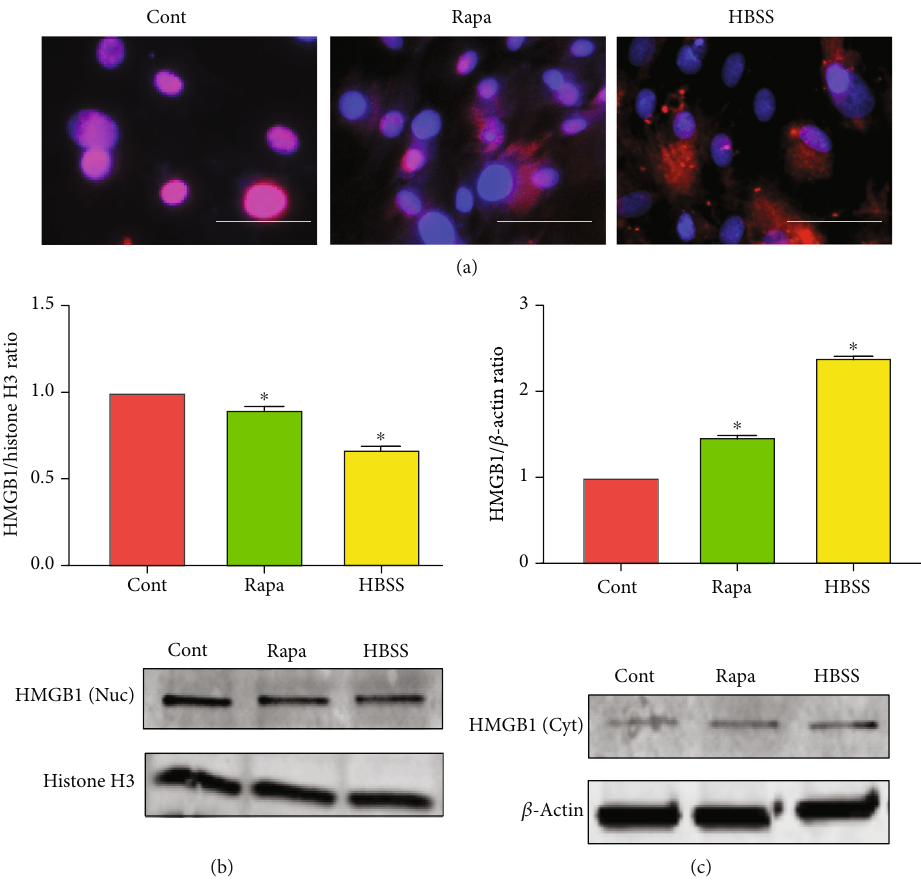
Figure 4: Rapamycin promotes translocation of HMGB1 from the nucleus to the cytosol. (a) HMGB1 translocates from the nucleus to the cytosol after rapamycin and starvation (HBSS) treatment. Rat PTSCs were treated with 25nM rapamycin for 12 h, starvation (HBSS) for 3h, then allowed a 12 h recovery, and then immunostained with HMGB1 (red) and Hoechst 33342 (blue). (b, c) Western blot analysis of HMGB1 in the nucleus (Nuc) and cytosol (Cyt) shows that rapamycin reduces nuclear HMGB1 levels but increases cytosol HMGB1 levels. Cells were subjected to nuclear/cytosol fractionation and immunoblotted against HMGB1. Histone H3 and β -actin were used as controls. Each data point in (b) and (c) represents at least three independent experiments. ∗ p < 0 : 05 , compared to the untreated group. Cont: control; Bleo: bleomycin; Rapa: